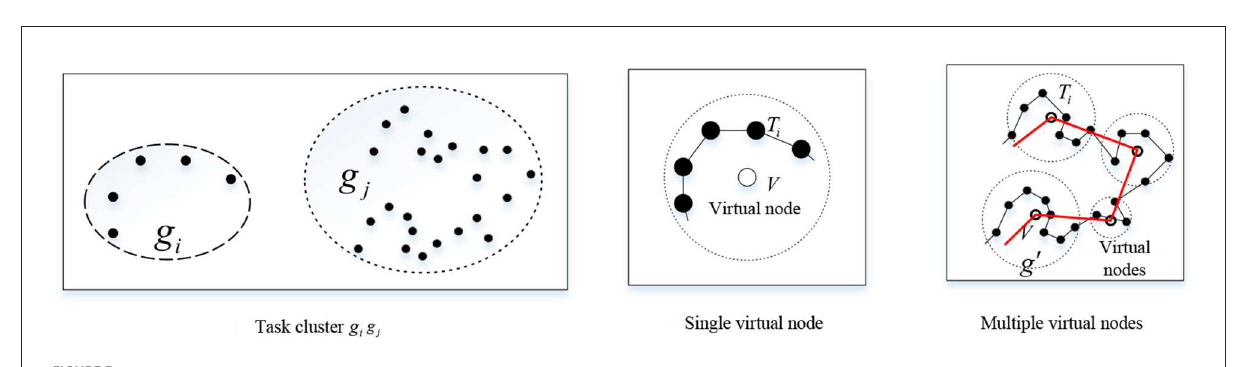
FIGURE3 Schematic diagram of virtual node